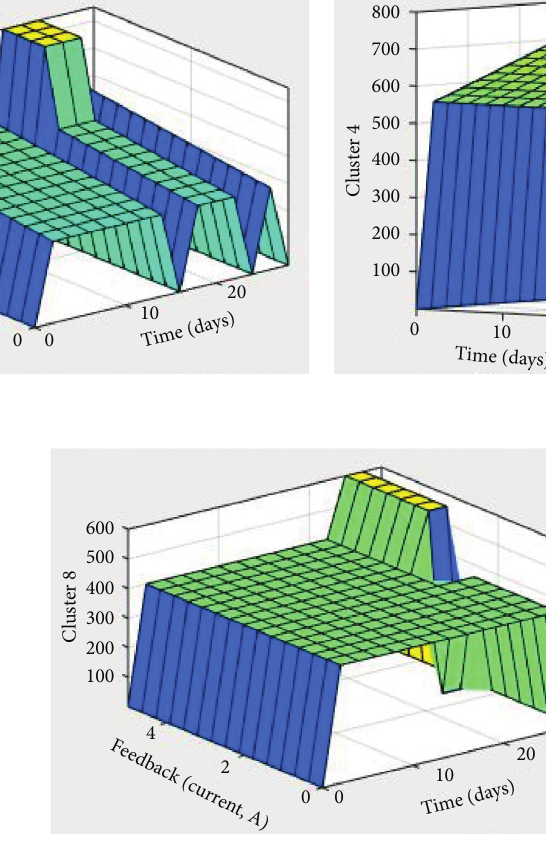
Figure 12: Surface view output representation for clusters 3, 4, and 8 after fuzzy